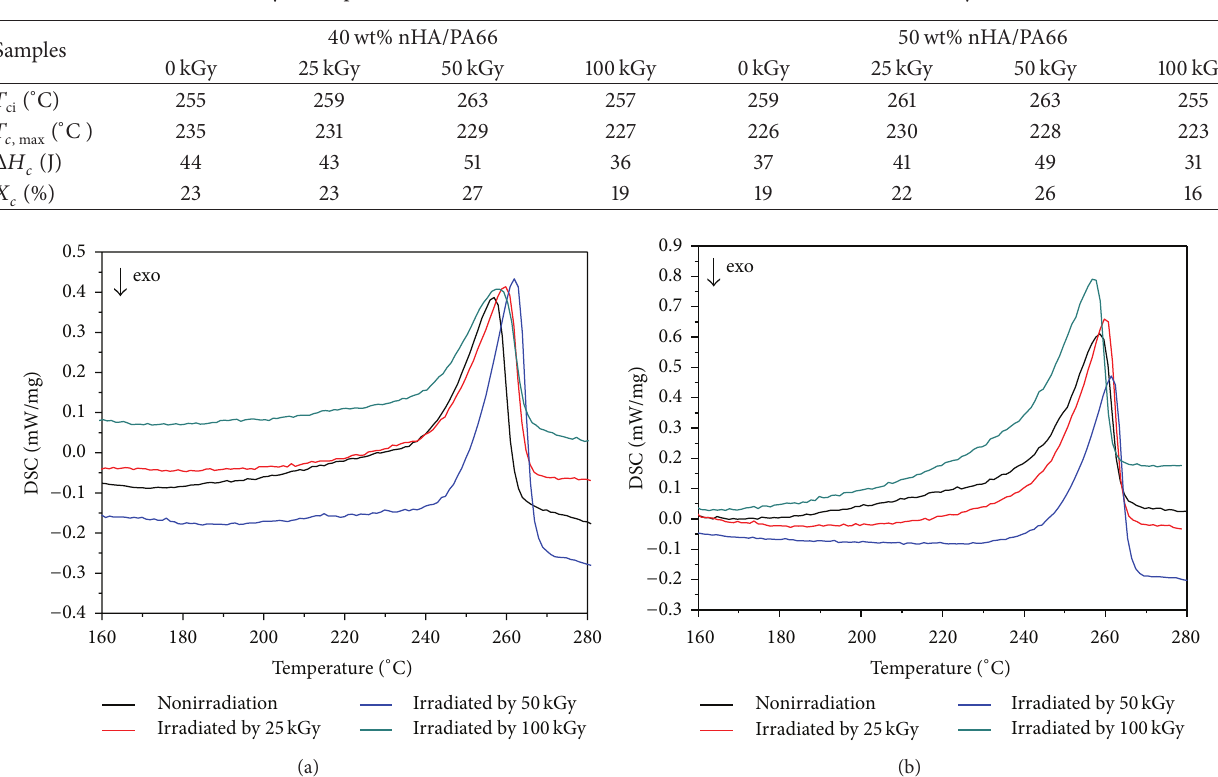
Table 5: Thermodynamic parameters of 40wt% nHA/PA66 and 50 wt% nHA/PA66 irradiated by different doses.